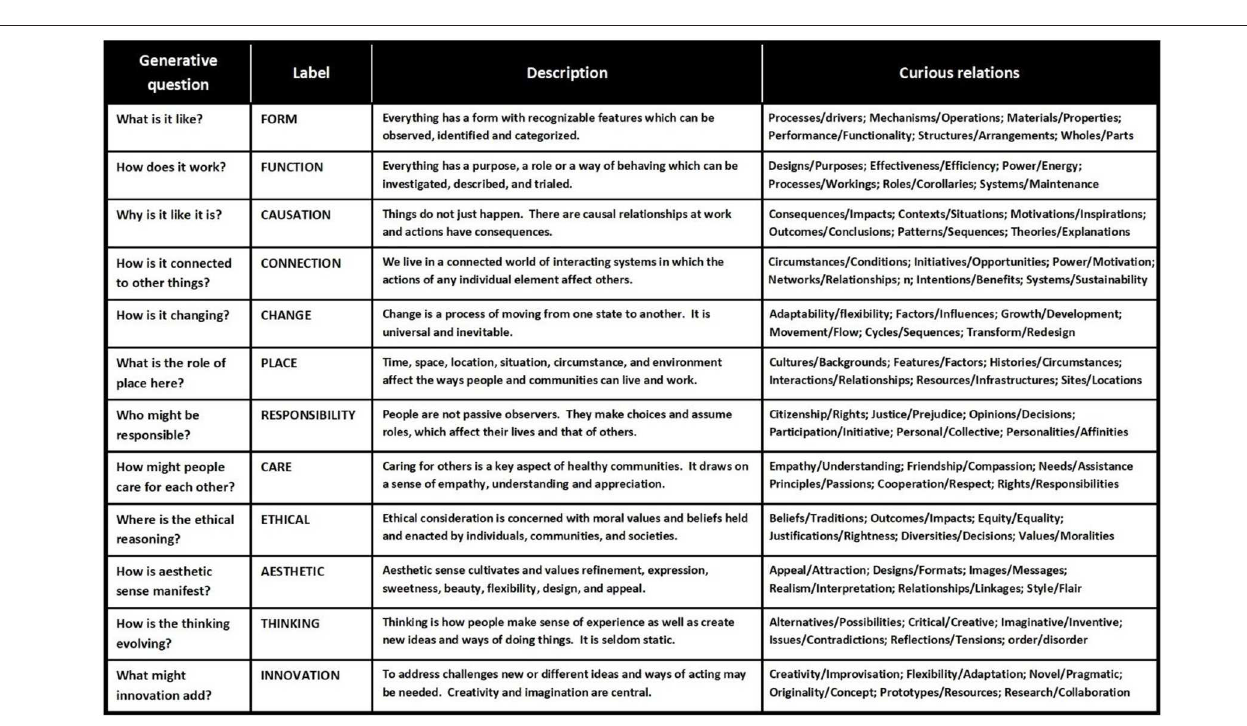
FIGURE 1 | Questions to connections. Reproduced with permission from Freestone (2007).